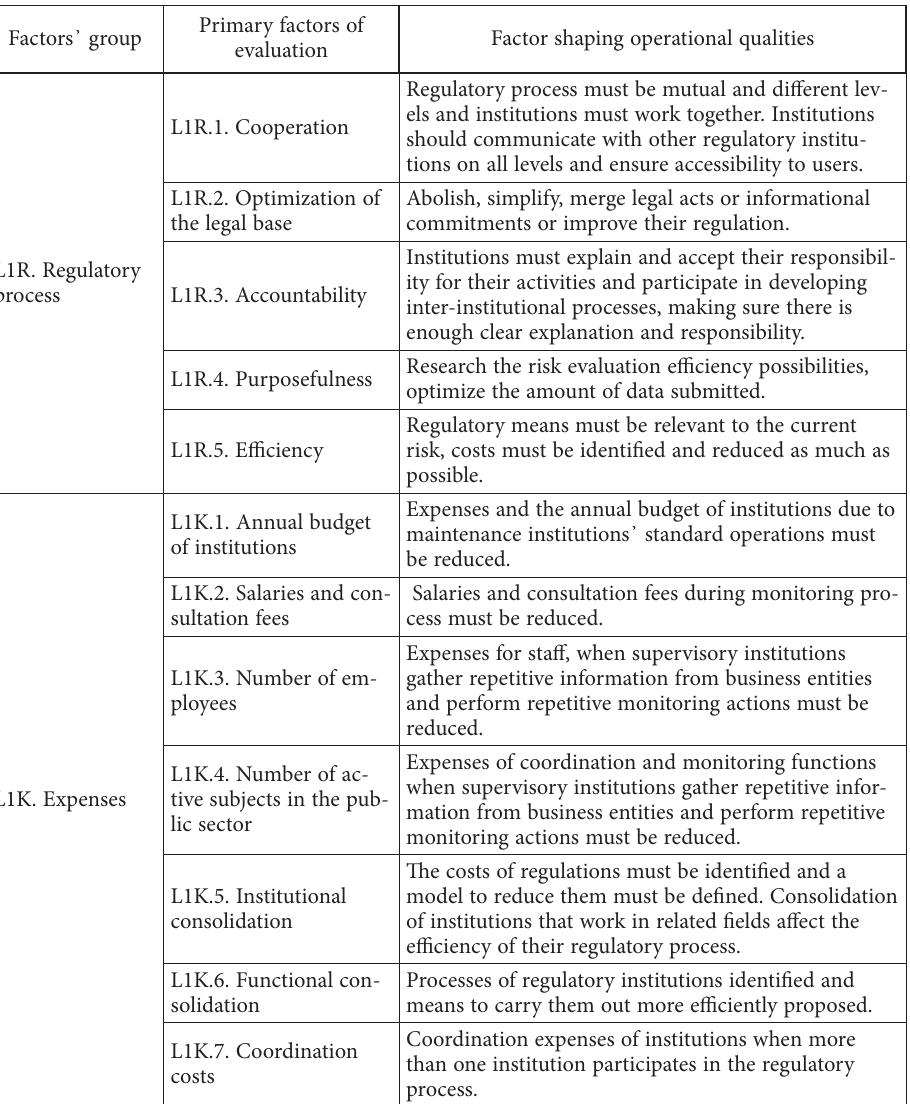
Table 3. Classification of factors on regulatory institutions’ level (created by the authors) Factors᾽